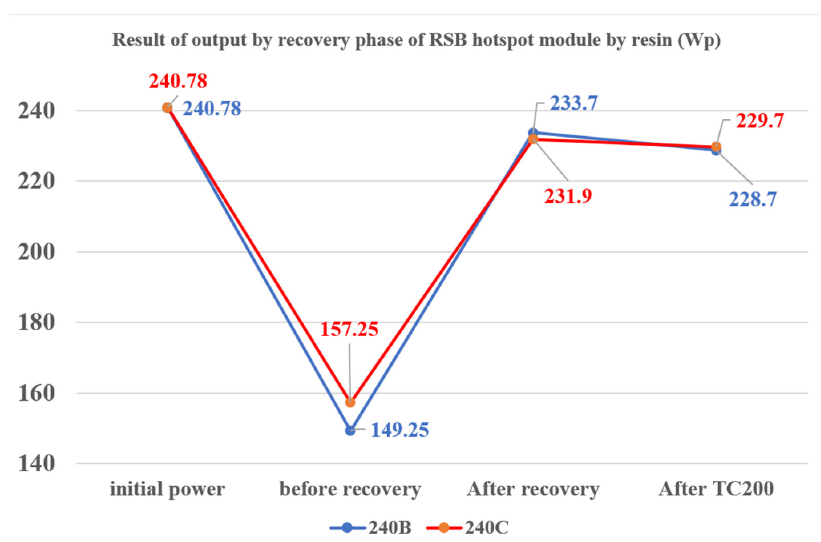
Figure 16. P max change of RSB hotspot module through on-site recovery method.